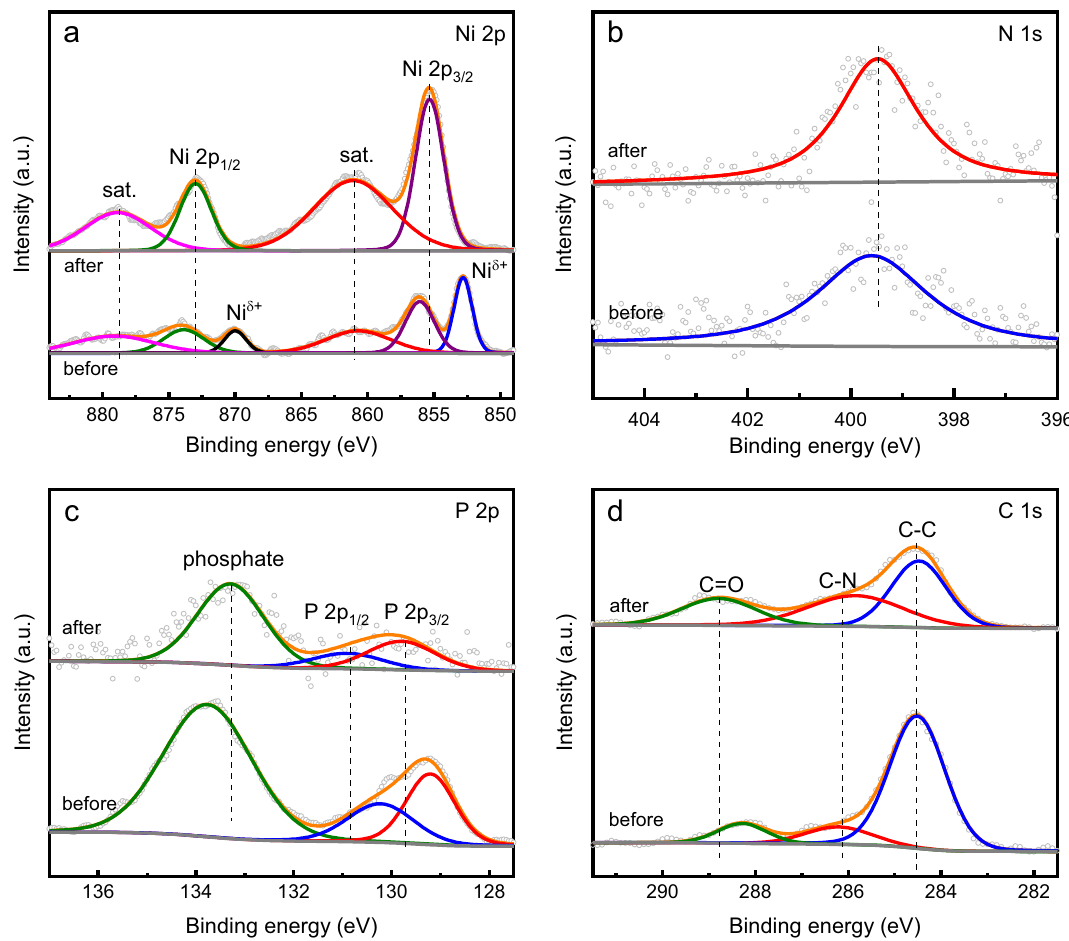
Figure 6. High resolution XPS spectra of ( a ) Ni 2p, ( b ) N 1 s, ( c ) P 2p and ( d ) C 1s in Ni 2 P@Ni-MOF/NF after durability